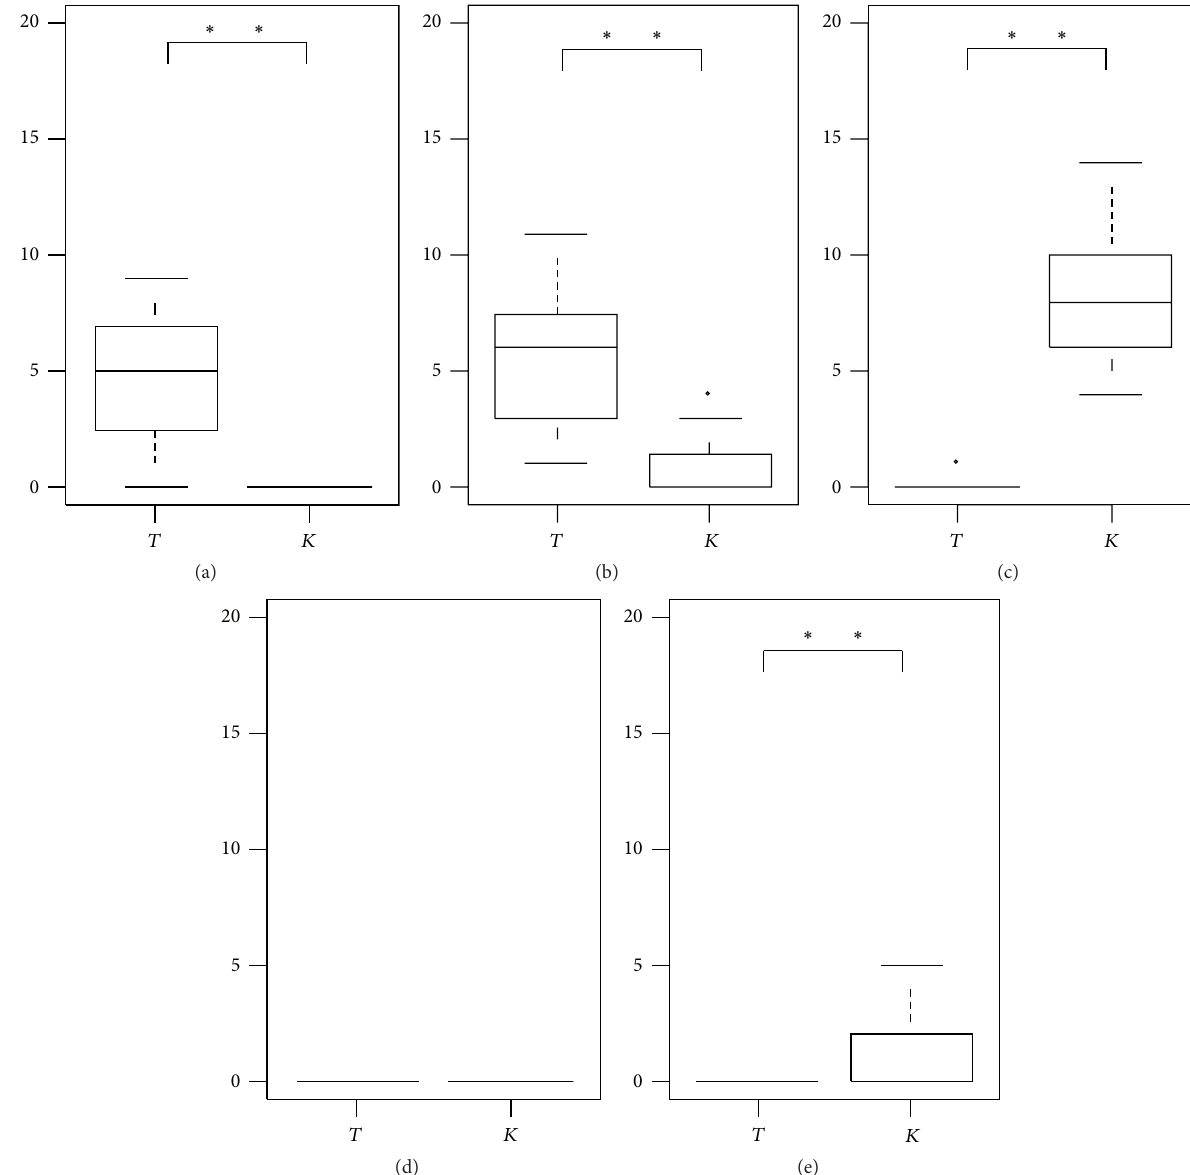
Figure 1: Behavior recognized in M. tetramorii (T) and in M. kubotai (K) in colonies of T. tsushimae . (a) Being attacked by ants and escaped from them immediately, (b) feed foods for themselves, (c) groom ant body, (d) muscle in trophallaxis between ants, (e) be done a feeding by direct mouth-to-mouth transfer by ants. Results of each behavior were based on averages of all individuals of each species ( 𝑁 = 20 ) observed. The box plot represents 25th, 50th, and 75th percentiles. The top and bottom whiskers represent largest and smallest nonoutlier observations, respectively. Dots represent outliners that are any value greater than 1.5 times the spread outside the closest hinge. ∗ 𝑃 < 0.05 , ∗∗ 𝑃 < 0.01 by Wilcoxon rank-sum